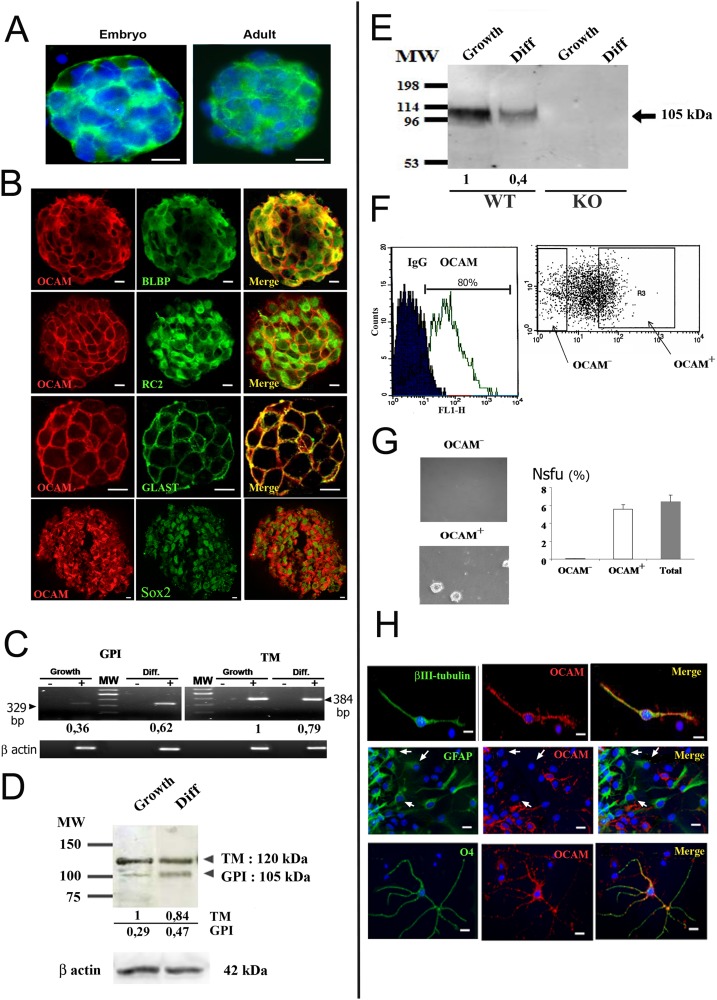
Expression of OCAM in spinal cord neural stem cells.(A): Detection by immunofluorescence of OCAM (green) in embryonic (left) and adult (right) spinal cord neurospheres. (B): OCAM is expressed by cells coexpressing BLBP, RC2, Sox2 and GLAST detected by immunofluorescence in embryonic spinal cord neurosphere cells (confocal images). A goat anti-OCAM antibody recognizing the external part of the protein was used for colabelling with BLBP, RC2 and GLAST whereas a rabbit antibody directed to the internal part of OCAM was used for labelling with anti Sox2 antibody. (C): PCR analysis of OCAM mRNA isoform expression in embryonic spinal cord neurospheres in growing condition (growth) or after 4 days of differentiation (diff.) Sizes (base pairs, bp) of amplified fragments are indicated. β-actin transcript amplification was used as an internal control. PCRs performed on RNA in which the reverse transcriptase step was omitted (-) demonstrate that the observed bands correspond to cDNA amplification and not genomic DNA. The TM isoform is predominant in growing neurospheres however only the GPI form increased after differentiation. (D): WB analysis of OCAM expression in protein extracts of embryonic spinal cord neurospheres in growing condition or after 4 days of differentiation. Both isoforms are detected. β-actin was used as an internal control. For C and D, the relative quantifications of bands are indicated at the bottom with TM band in growing condition taken as reference. (E): WB detection of OCAM in the media conditioned for 5–7 days by neurospheres. Media conditioned by OCAM KO cells was used as negative control. Compared to neurosphere extracts in (D), a small soluble form of OCAM, corresponding to the size of the GPI-linked isoform, is found in the supernatant. Relative quantifications of bands are indicated at the bottom. (F): Cytometry for OCAM. Left: Cytometric analysis indicated that the vast majority of neurosphere cells expressed OCAM. Incubation of the cells with non immune goat IgG was used as a control (IgG). Right: dot plot of OCAM-antibody incubated cells showing the population of OCAM- and OCAM+ cells used to perform the neurosphere forming assays in (G). (G): Neurosphere-forming assays performed in clonal conditions showed that OCAM- cells were unable to form neurospheres unlike OCAM+ cells which form neurospheres at the same rate as the total population. This latter went through the cytometer but was unsorted. The neurosphere forming cell unit (Nsfu) indicates the percentage of neurospheres >500μm obtained after clonal seeding of indicated cells. Photographs show cultures obtained from OCAM- or OCAM+ cells one month after sorting. (H): Expression of OCAM after neurosphere differentiation. OCAM is expressed in neurons (βIII tubulin), oligodendrocytes (O4) but not in astrocytes (GFAP) (white arrows). Scale bars = 10 μm.